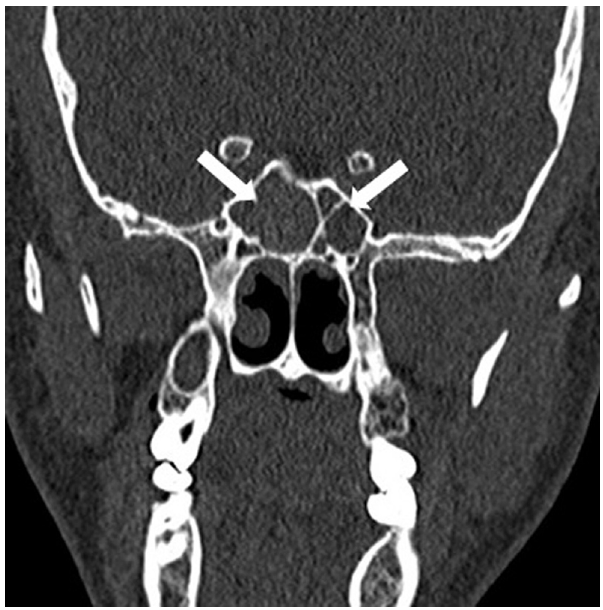
Figure 2 The CT scans of the paranasal sinuses shows bilateral sphenoiditis (arrows). OC-negative ( n = 35) or only contralateral OC-positive ( n = 13) (Table 1). The co-existence of OC ipsilaterally was observed to increase the identification of sphenoiditis 1.5- fold, and this finding was statistically significant ( p < 0.05) (Fig. 3). There were 280 (56.3%) male patients and 217 (43.7%) female patients in the control group. Of the control group, 48.3% ( n = 240) were OC-positive, whereas 51.7% ( n = 257) were OC-negative. Of the 240 OC-positive patients of the control group, right-sided OC was identified in 13.9% ( n = 69) patients, left-sided OC in 11.3% ( n = 56) patients, and bilat- eral OC in 23.1% ( n = 115) patients.